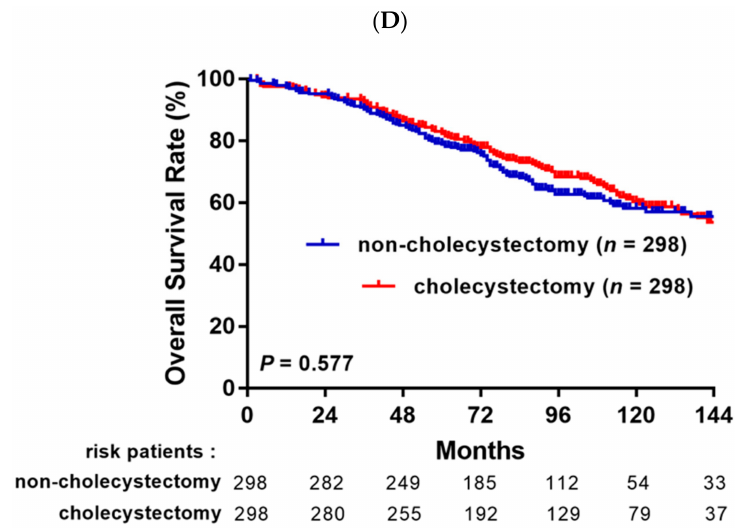
Figure 2. Recurrence-free survival (RFS) and overall survival (OS) after resection for HCC patients with or without cholecystectomy before propensity score matching (PSM) ( A , B ) and after PSM ( C , D ).